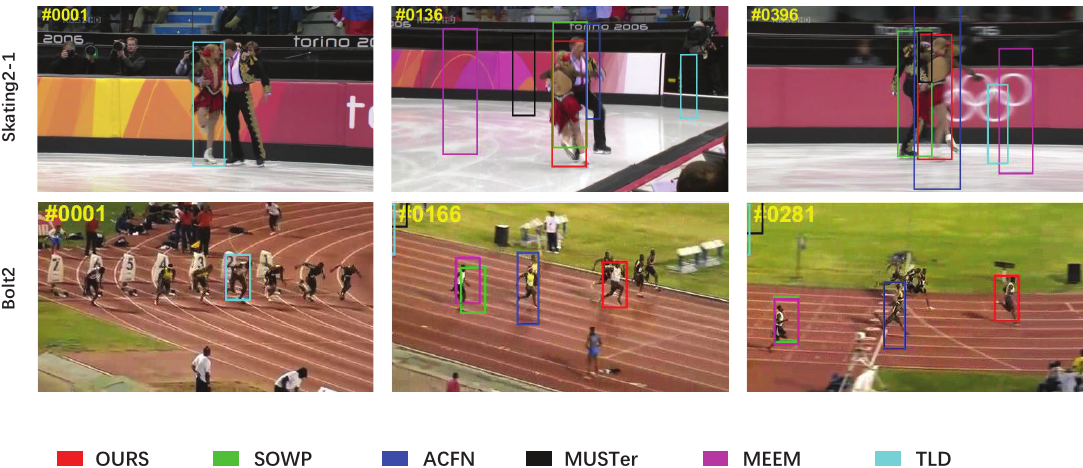
Figure 1. The illustration of background information redundancy in the bounding box caused by fast motion and background clutter, “Skating2-1” and “Bolt2” are from the OTB-100 (object tracking benchmark) dataset [17]. The compared visual tracking algorithms including the spatially-ordered and weighted patch descriptor (SOWP) [10], ACFN (Attentional Correlation Filter Network) [18], MEEM (Multiple Experts Using Entropy Minimization) [19], MUSTer (MUlti-Store Tracker) [20], TLD (Tracking-Learning-Detection) [21] and